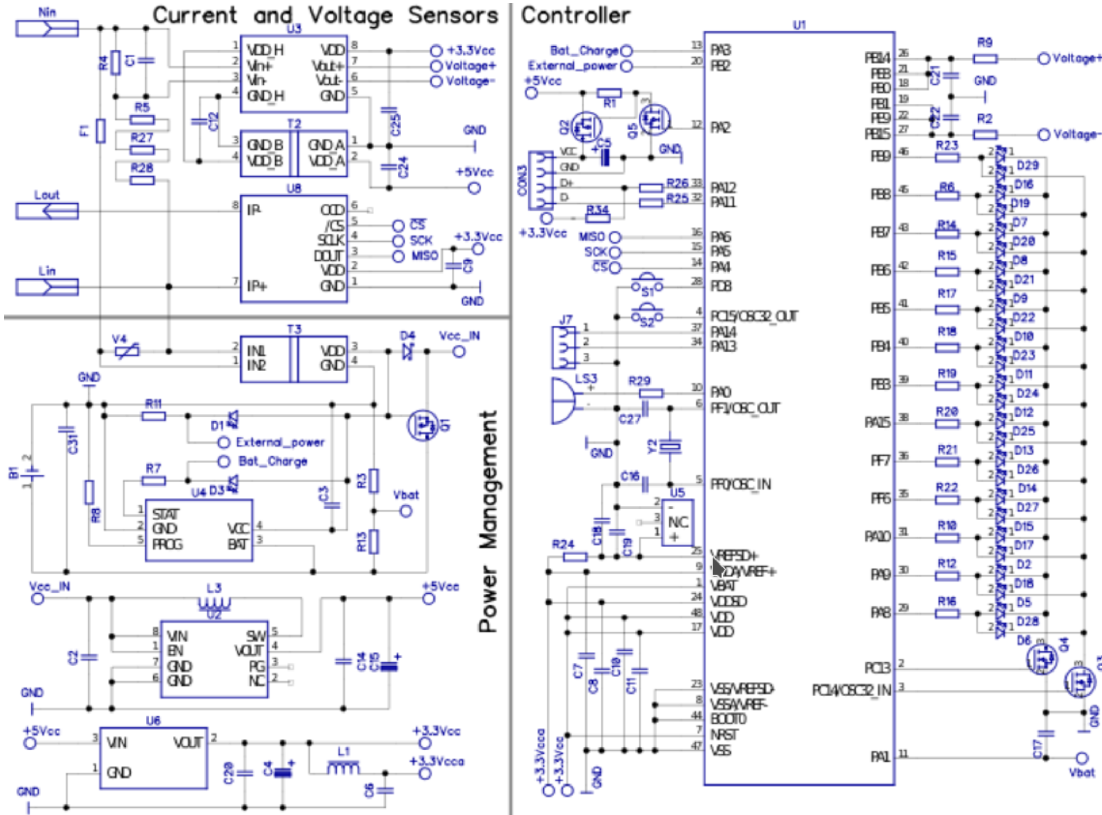
Figure 3. Electronic scheme of single-phase device. Controller, current/voltage sensor, and power management are